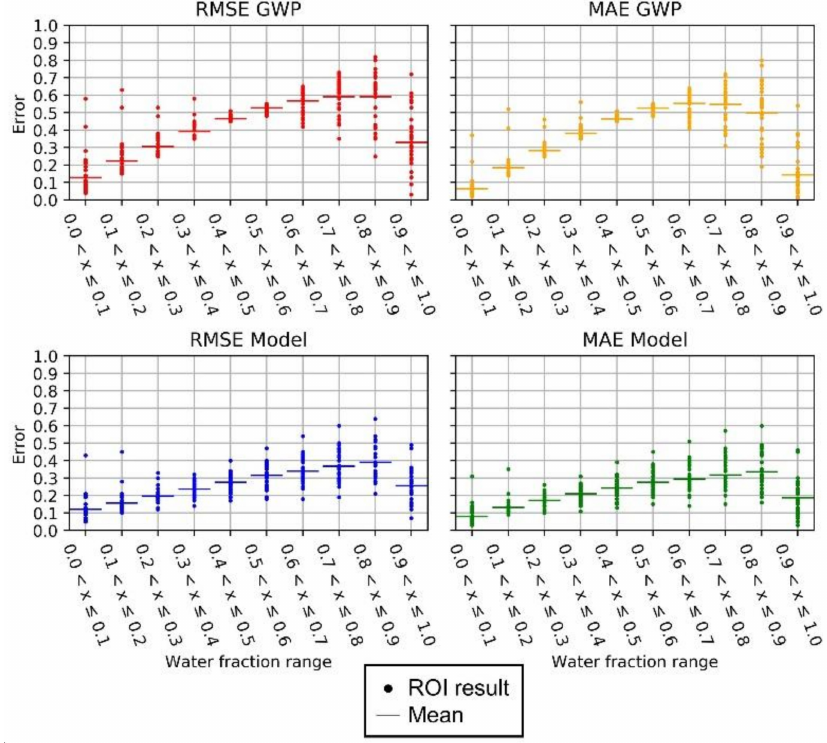
Figure 10. Model and GWP performance in all ROIs for specific intervals of partially water- covered pixels.